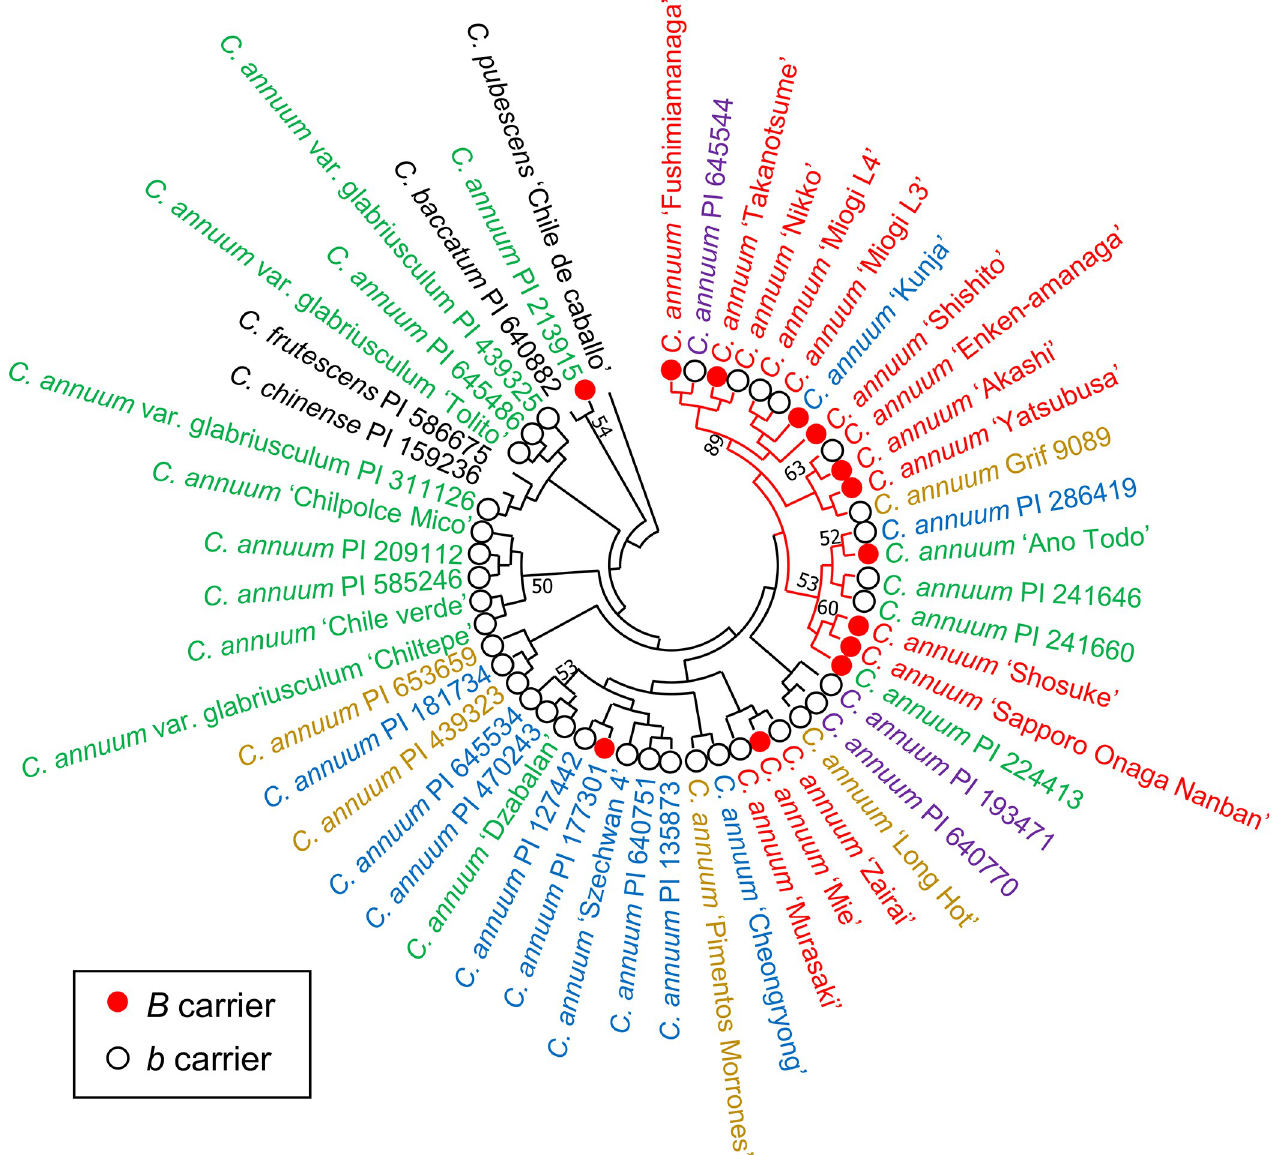
Fig 3. Phylogenetic NJ trees of 48 accessions of C . annuum with 4 other species based on 34 SSR markers. B or b carriers are indicated as red or white circles, respectively. The branches in the clade with high percentage of B carriers are shown in red.